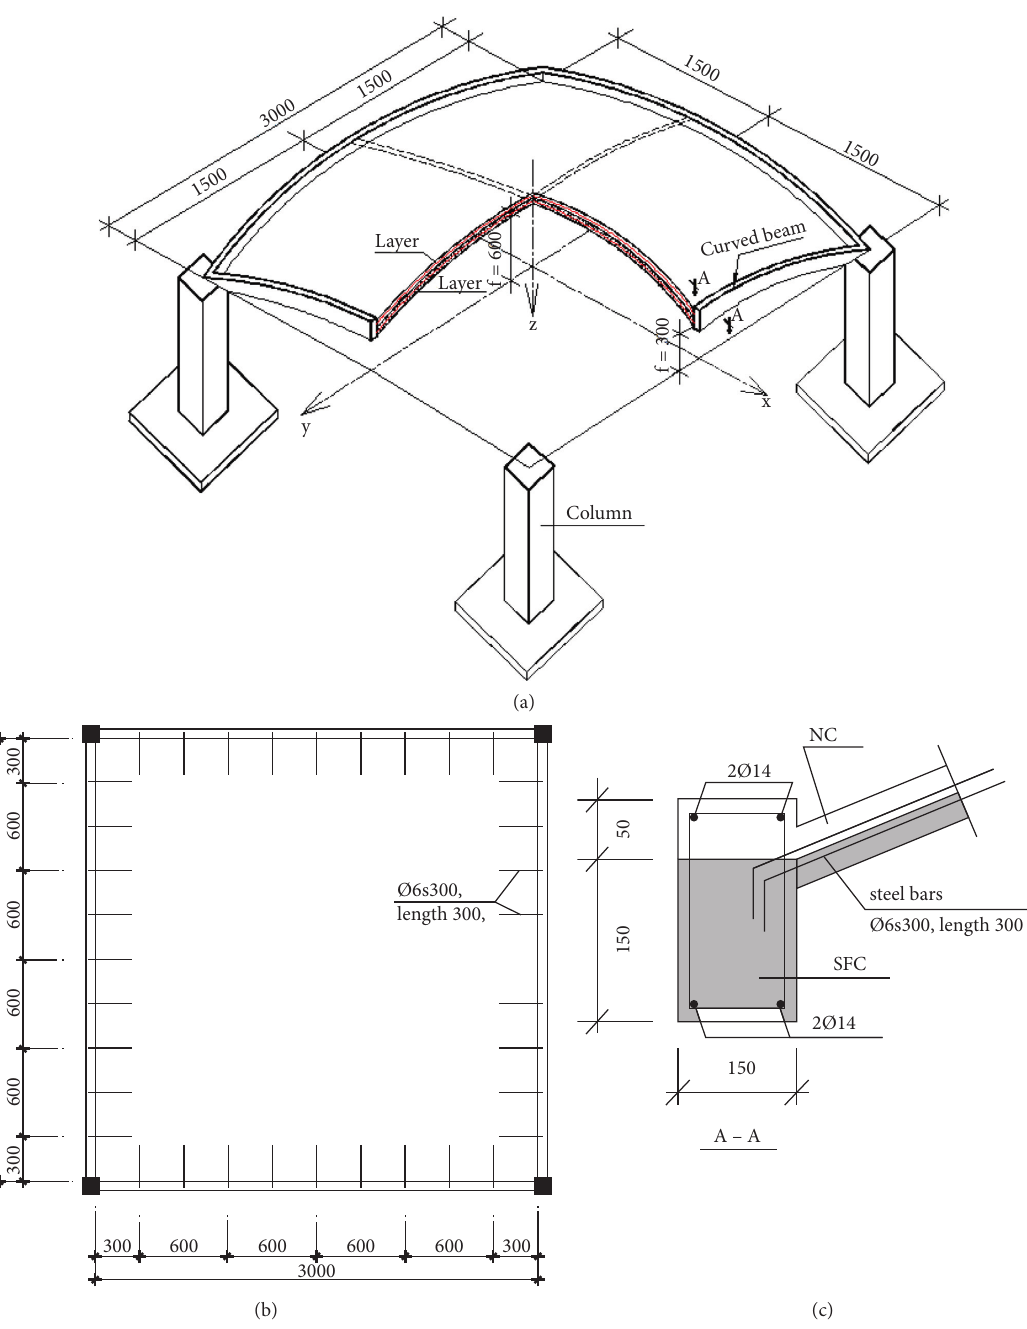
Figure 1: Doubly curved shell with double-layer, 3000 × 3000mm. (a) Doubly curved shell model, (b) plan of steel bars connected between the shell and curved beams, and (c) A-A